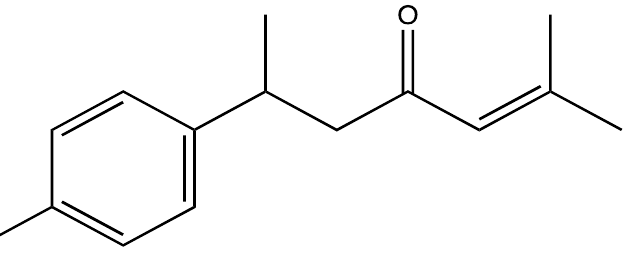
Figure 14. Structure of ar-turmerone, a major active component of C. Loga essential oil.